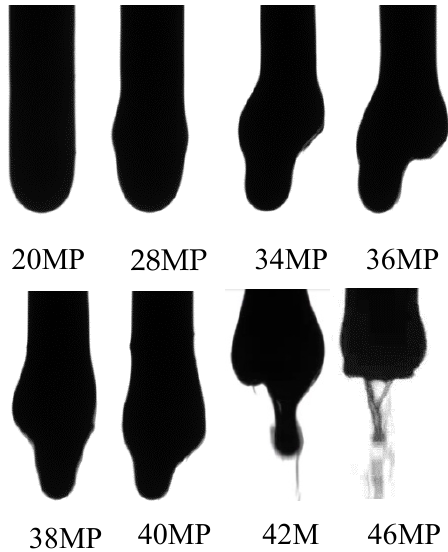
Figure 3. Droplet shapes under di ff erent pressures after adding petroleum ether in the crude oil. The calculated CO 2 –oil IFTs under di ff erent pressures are shown in Table 2. Although the MMP could have been determined by observing the corresponding pressure when the oil droplet could not be formed, the experimental process would have been longer, and the process control would have been di ffi cult. Figure 4 shows that the IFT had a linear relation with pressure; therefore, the CO 2 –oil MMP could be obtained with the linear extrapolation method. The calculated CO 2 –oil MMPs for the original crude oil and the mixture of crude oil and petroleum ether were 50.86 MPa and 42.70